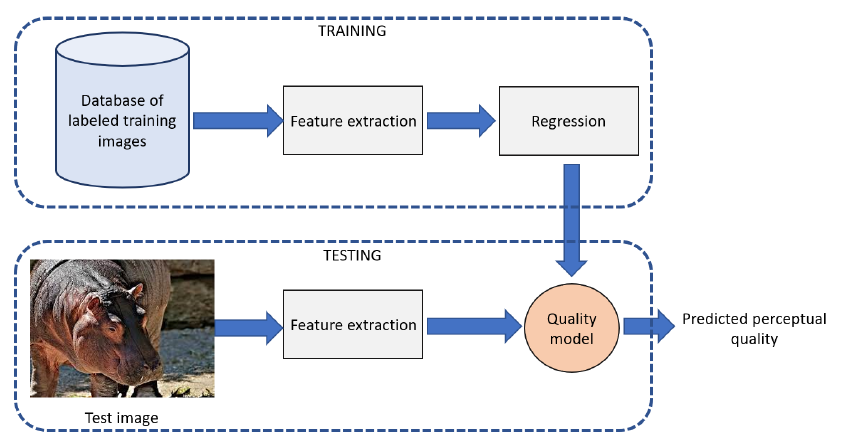
Figure 2. High-level overview of the proposed NR-IQA algorithm.